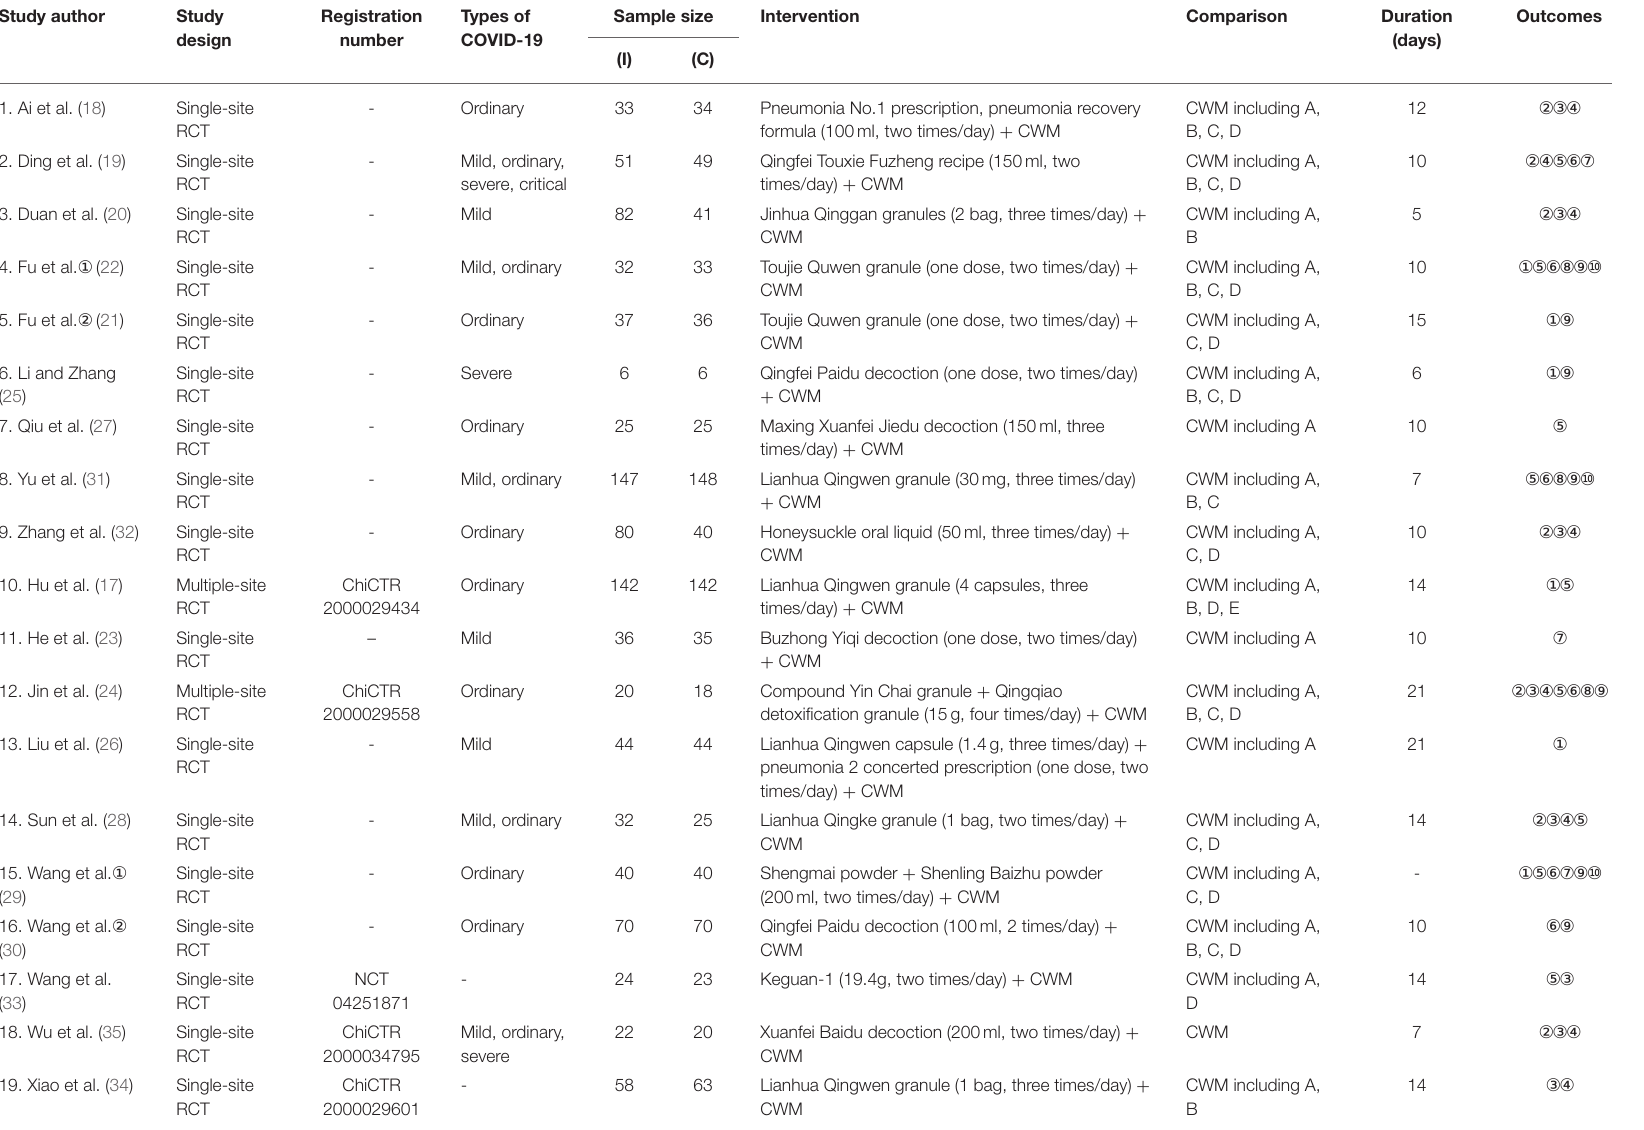
TABLE 1 | Baseline characteristics of the included studies.